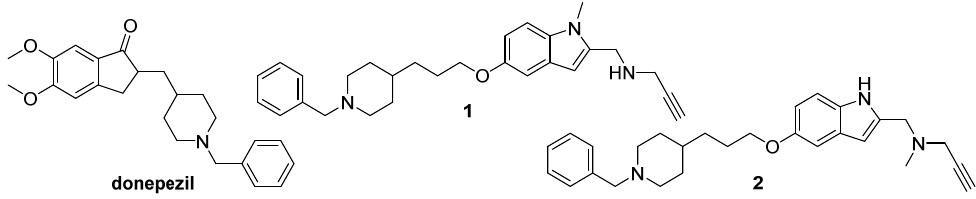
Figure 6. Chemical structure of donepezil and two new multi-target ligands against Alzheimer’s Disease (AD) [153,154].